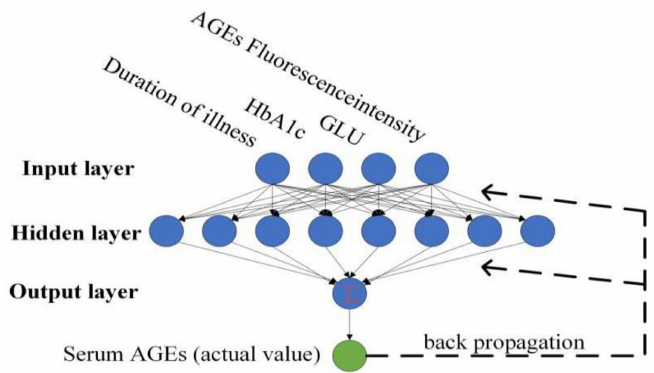
Figure 7. The BPNN model used for